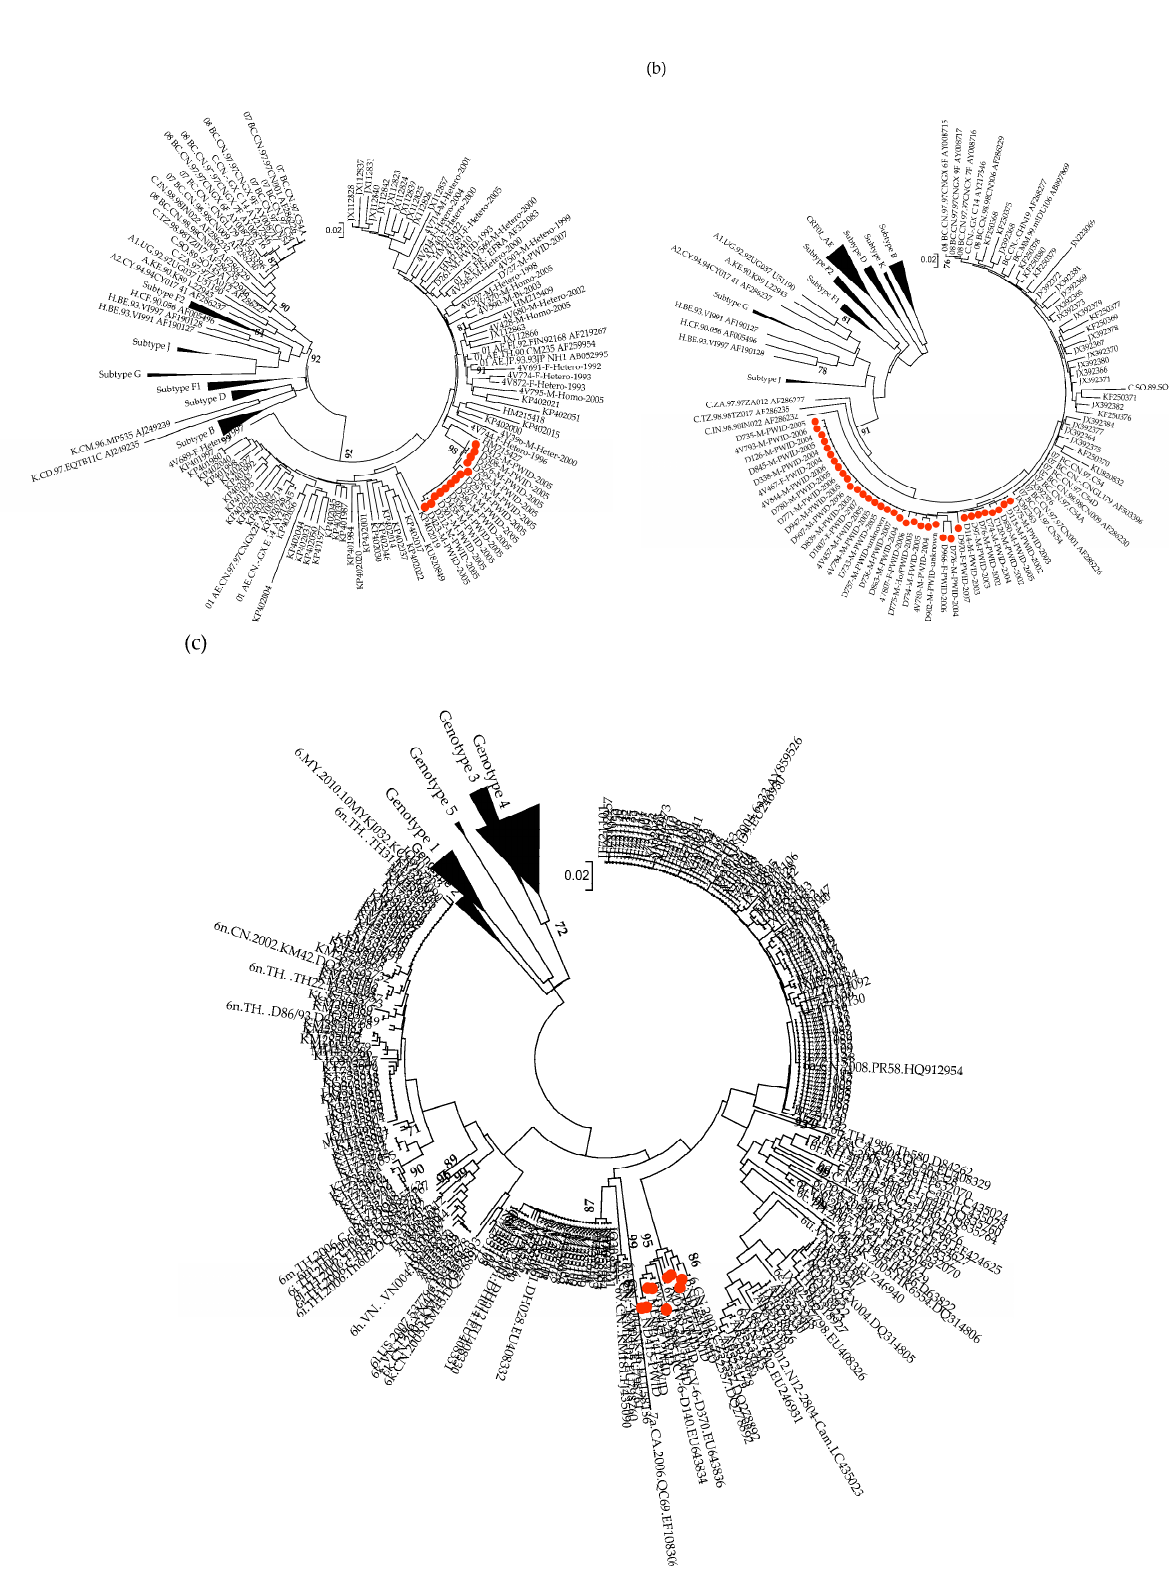
Figure A2. Phylogenetic analysis of HIV-1 CRF01_AE, CRF07_BC, and HCV sequences among Asian PWID. ( a ) CRF01_AE, the NJ tree was constructed using MEGA under the TN93 + G model with 1000 bootstrap replicates. ( b ) CRF07_BC, TN93 + G and ( c ) HCV, K2 + G. The red point indicates the Taiwanese PWID sequences.